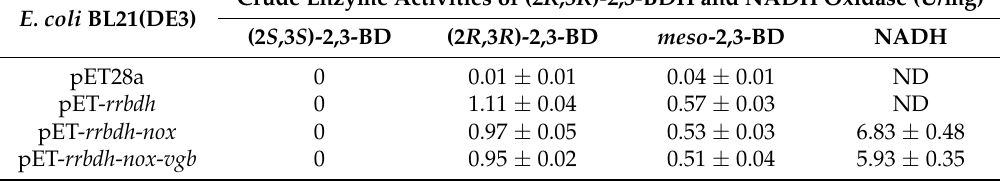
Table 2. Activity assays of (2 S ,3 S )-2,3-BDH and FDH in the recombinant E. coli strains. ND: not detected. E. coli BL21(DE3)